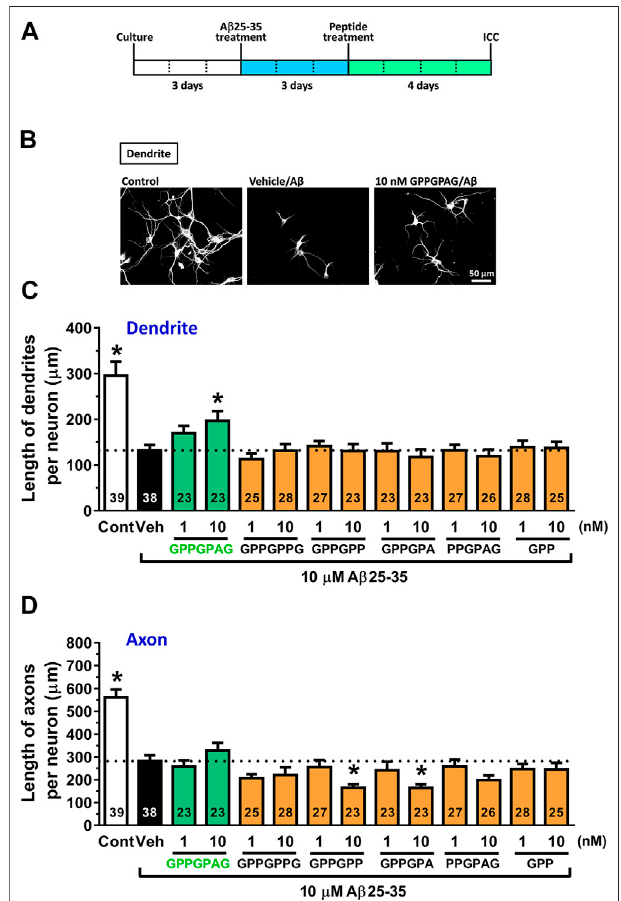
FIGURE1| EffectofGPPGPAGonA β -inducedatrophyofdendritesand axons (A) Cortical neurons were cultured for three days and then treated with or without aggregated A β 25 – 35 (10 μ M). Three days after the administration of A β 25 – 35, the cells were treated with six types of peptide (GPPGPAG, GPPGPPG, GPPGPP, GPPGPA, PPGPAG, and GPP) at 1 and 10 nM concentration, or vehicle solution (Veh; distilled water). Four days after the treatment, the cells were fi xed and double-immunostained for MAP2 and pNF-H. (B) RepresentativephotosoftheMAP2-positive dendrites areshown. The density of MAP2-positive dendrites (C) and pNF-H-positive axons (D) was quanti fi ed for each treatment. * p < 0.05, vs. A β 25 – 35-treated vehicle solution group, one-way ANOVA with post hoc Bonferroni ’ s test, mean ± standard error. Each number of samples is shown in columns. Scale bar indicates 50 μ